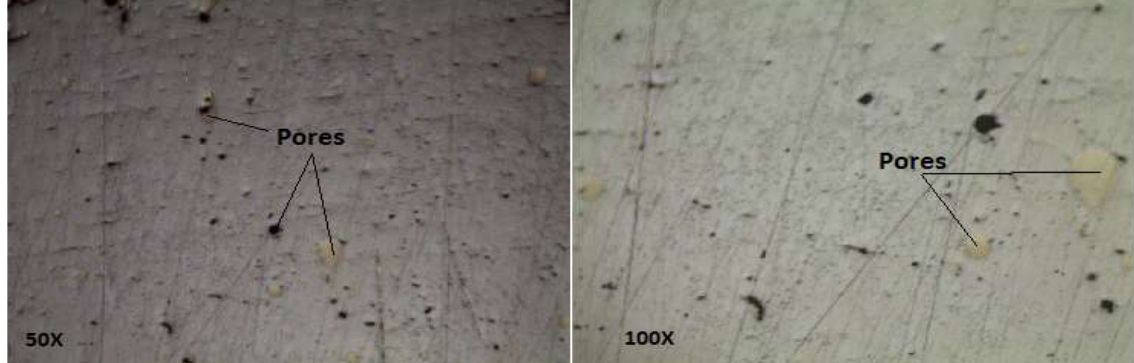
Fig.2 . Microstructures of Ni-Cr alloy plated sample at 8 A/dm 2 current density and plating time of 10 min for 50X and 100X magnification.